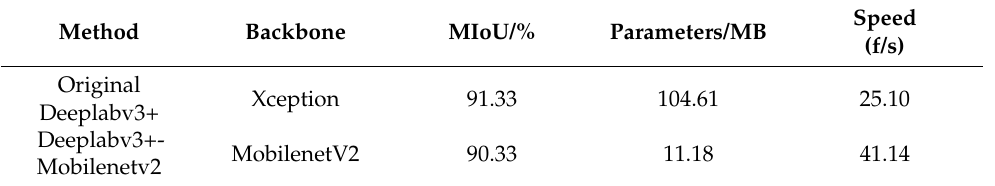
Table 5. Comparison of the influence of different backbone